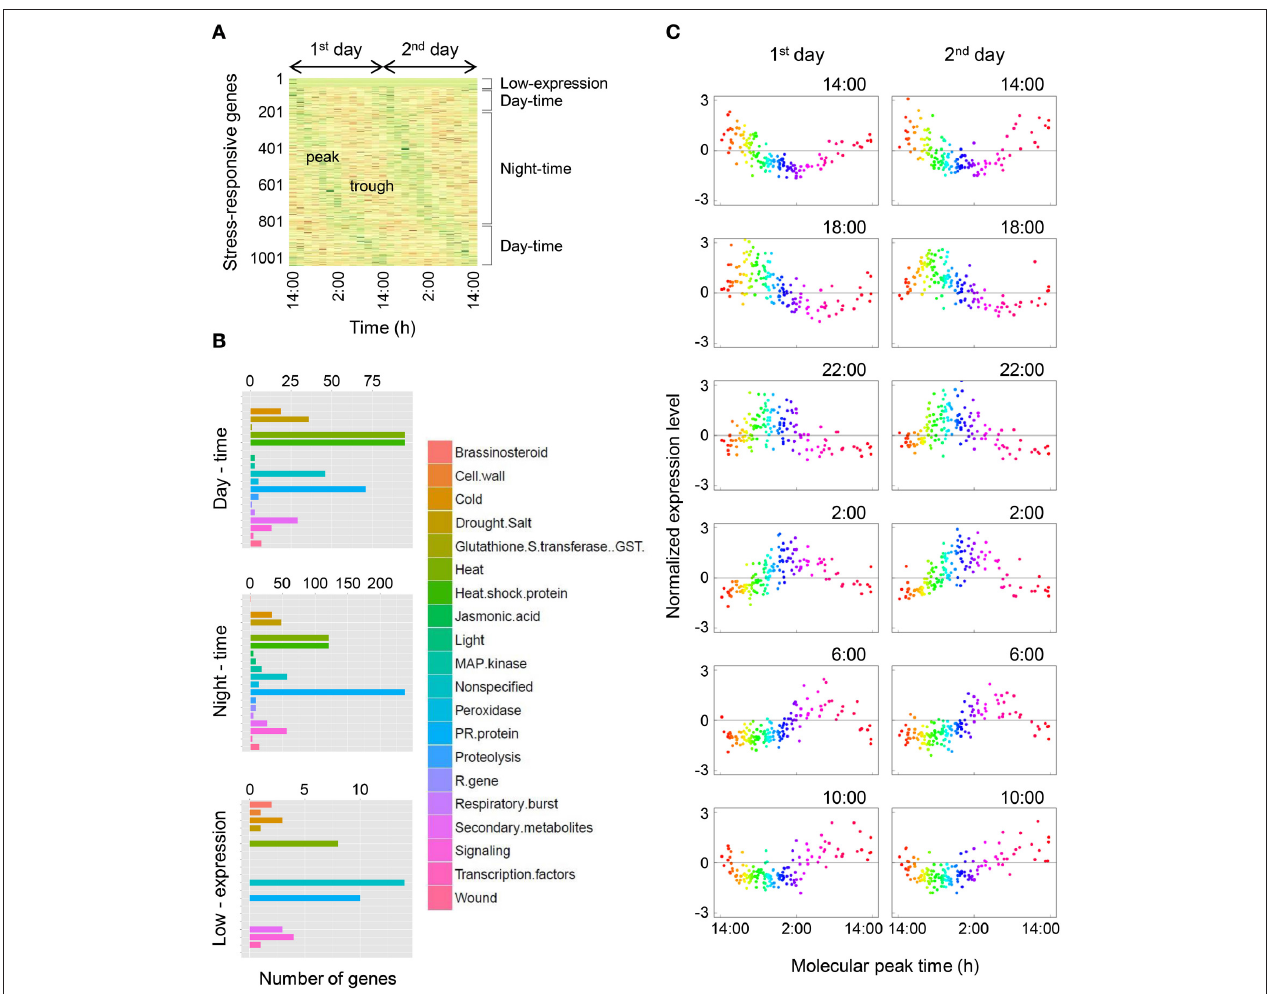
FIGURE 4 | Diurnal gene expression profiles of stress-responsive genes. (A) Oscillation behavior of stress-responsive genes. Green areas indicate the peak and red areas indicate the trough. (B) Categorization of stress-responsive genes using MapMan. Day-time was 7:00–17:00 (10h) and night-time was 17:00–7:00 (14h). (C) Expression profiles of 150 time-indicating genes for the 1st and 2nd days in stress-responsive genes. The time at the top right of the plot area indicates the sampling time. The range from orange to purple represents night-time and other colored areas represent